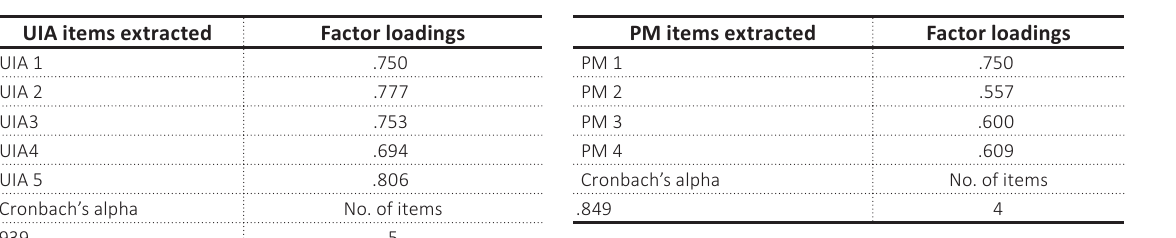
Table 3. Factor: Usefulness of Inflation Accounting Technique (UIA)